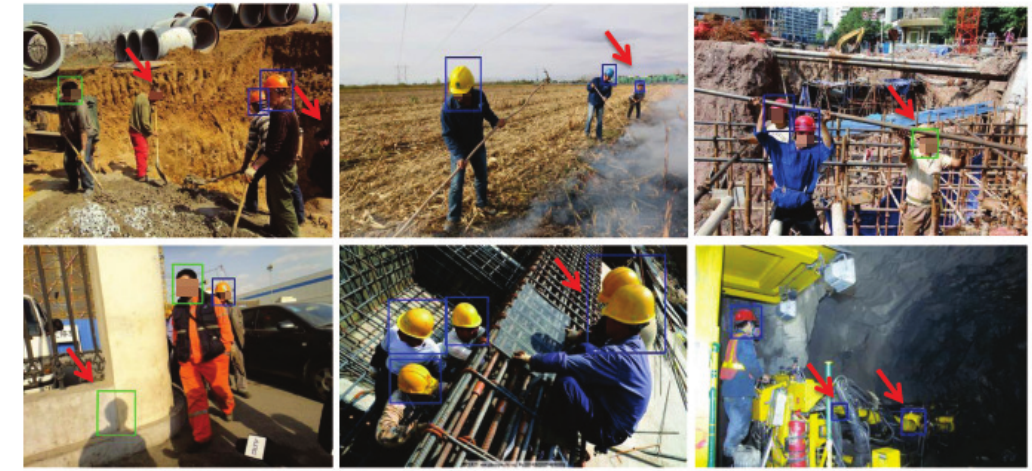
Figure 5. Examples of failure